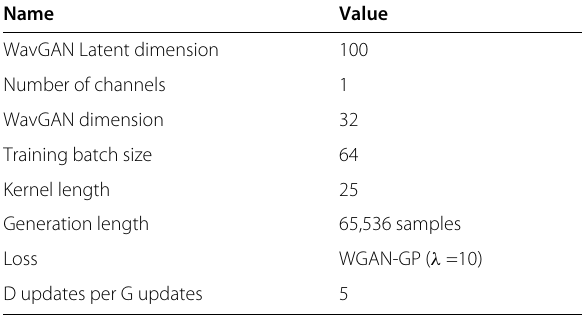
Table 2 Various hyperparameters chosen for